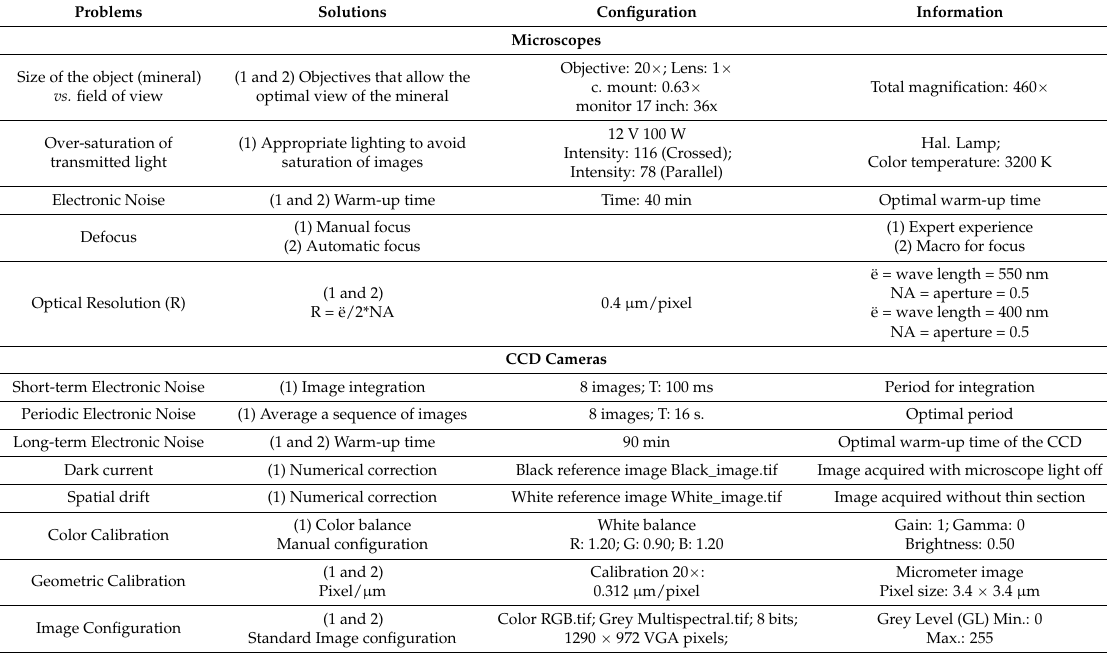
Table 2. Basic configuration of the optical microscope and digital camera to ensure the reproducibility of the measurements to be performed on polished sections. The configuration parameters are stored in the OIA-software that controls the digital camera and the microscope. RGB System is (1) and Multispectral System is (2) in the table. Modified from [6,32,47]. Problems Solutions Configuration Information